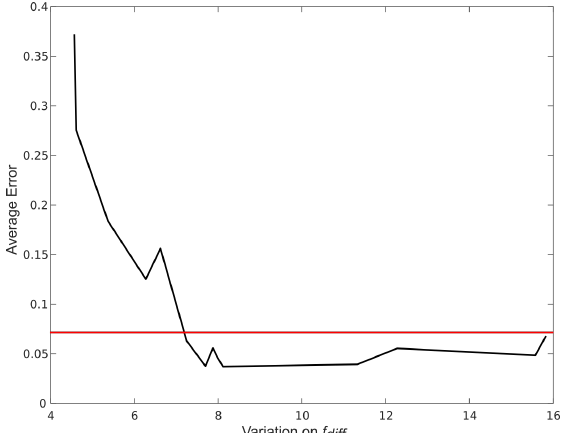
Figure 7. The average relative error of gait parameters obtained from the i-Walker order of increasing variation on f dif f .